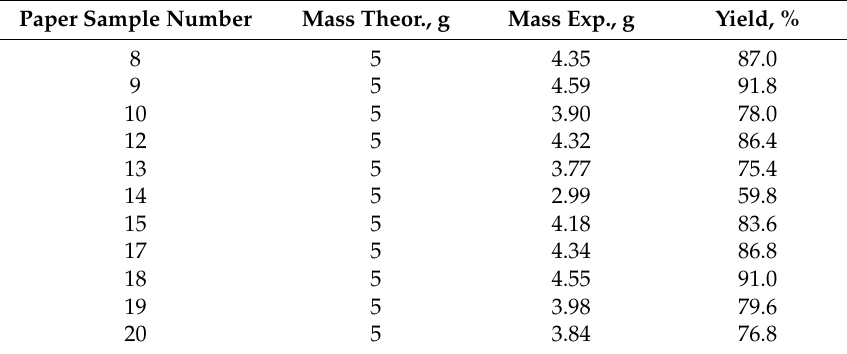
Table A2. The values of